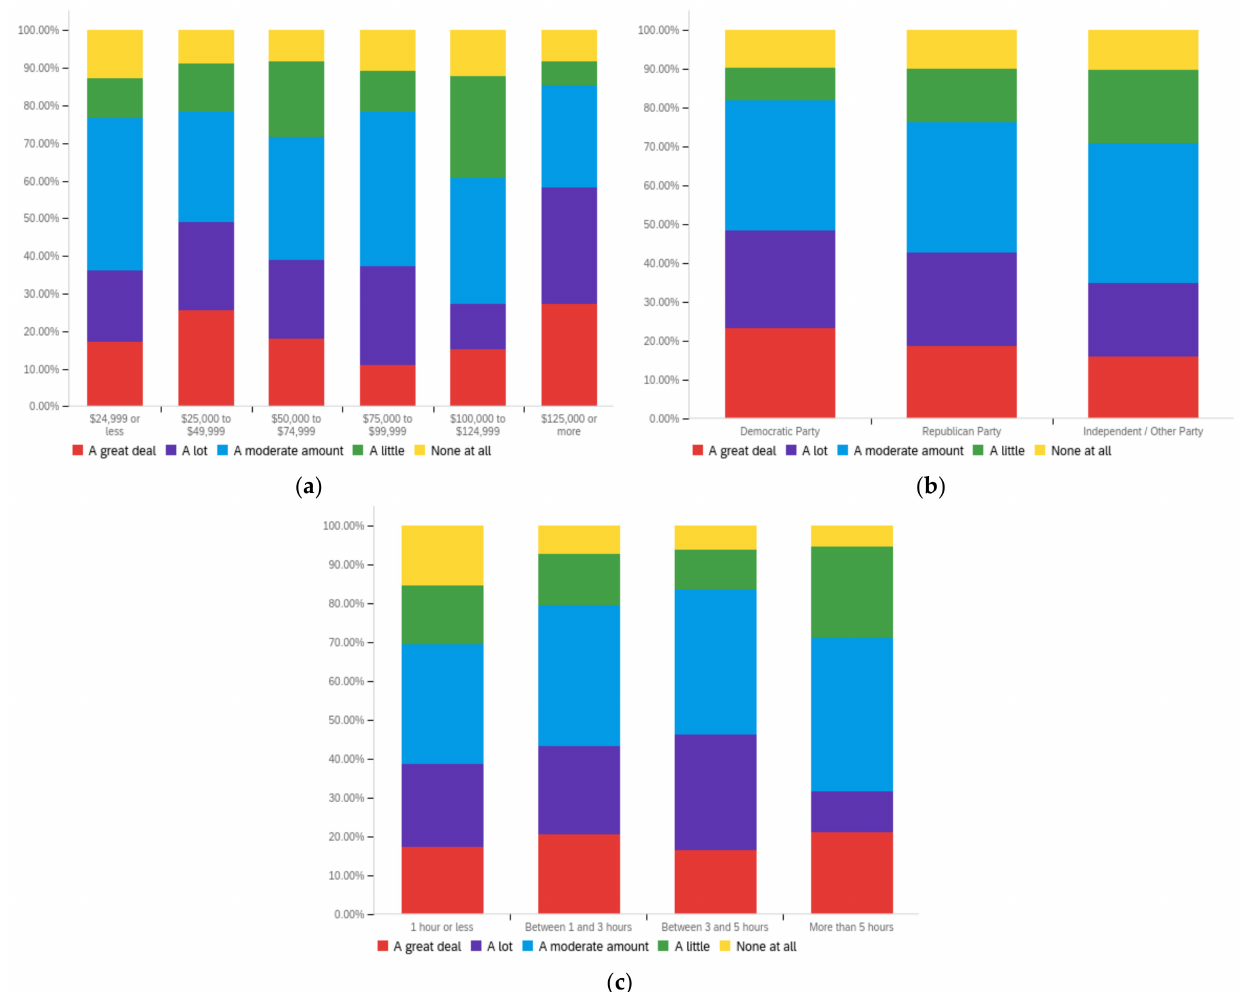
Figure A25. Article opinion statement quantity—personal perception impact by: ( a ) income level (top left), ( b ) political affiliation (top right) and ( c ) online usage (bottom).